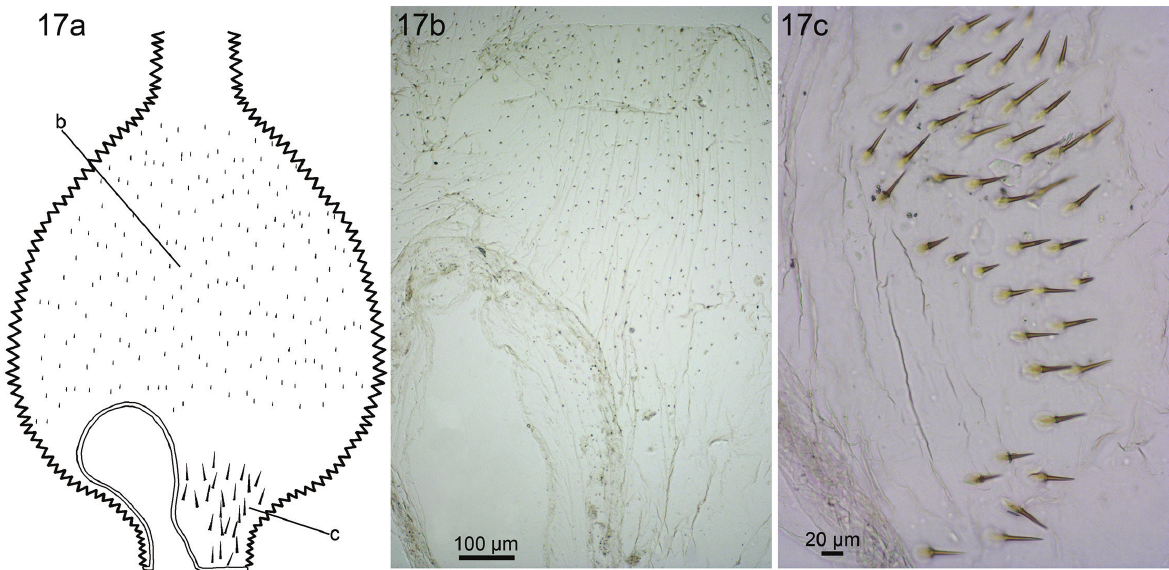
Figure 17. Macuxitermes triceratops . (a) Schematic drawing of P1 showing arrangement of spines. (b, c) Photomicrographs: (b) General view of the short spines in the distal region; (c) Set of aciculiform spines in detail.